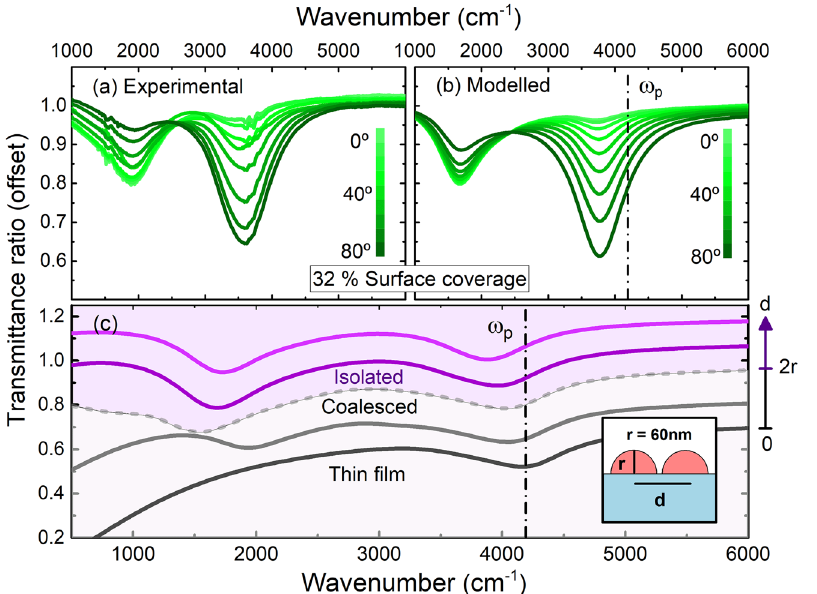
Figure 3: (a) Measured transmittance curves of the 32% surface coverage sample. (b) Computational transmittance curves from the isolated NP model with the same surface coverage. (c) 45 ° transmittance: Effect of near fi eld interaction and coalescence in a periodic model. The curves in purple light field represent an uncoalesced stage with center-to-center distances (d in the figure) of 150 and 130 nm, larger than twice the radius of the NPs, r =60 nm. Graycurves correspond to a coalesced stage with d values ranging from 120 (dashed line) to 0 nm (thin fi lm limit) with an intermediate value of d = 116 nm.